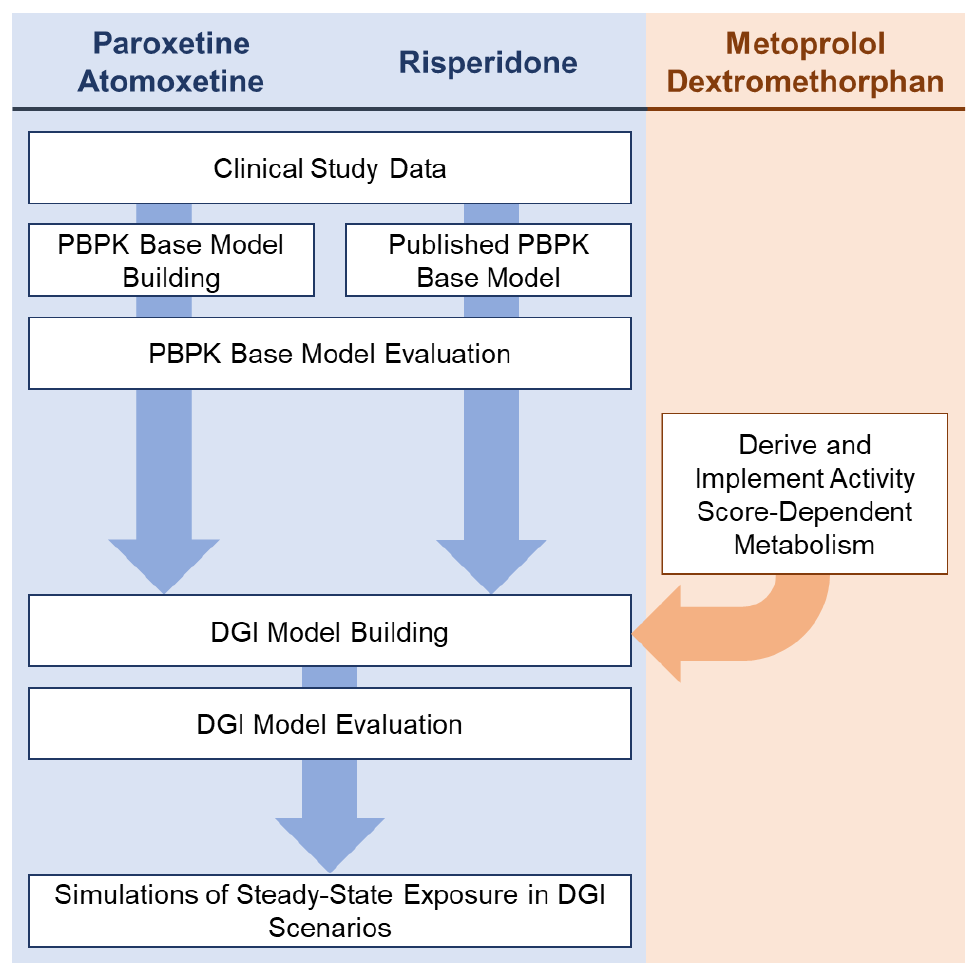
depicts the workflow for this study.